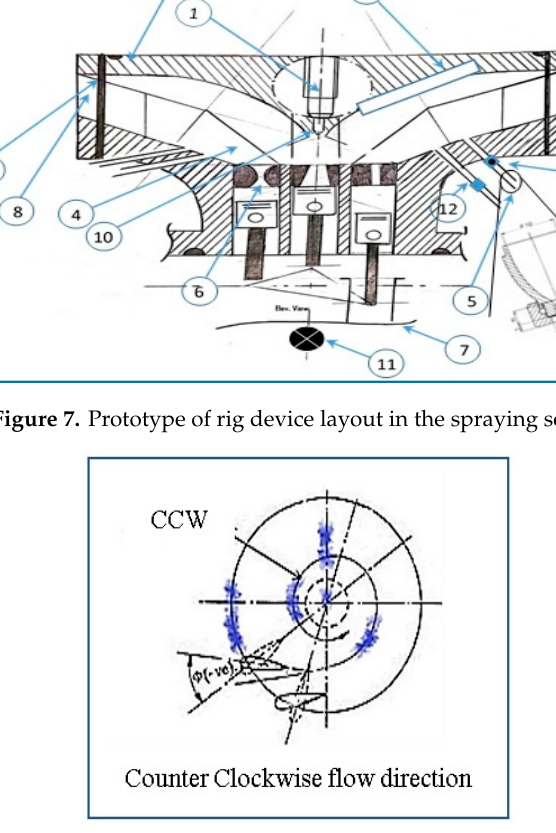
Figure 8. The two vanes’ angle-setting viewer from the top.